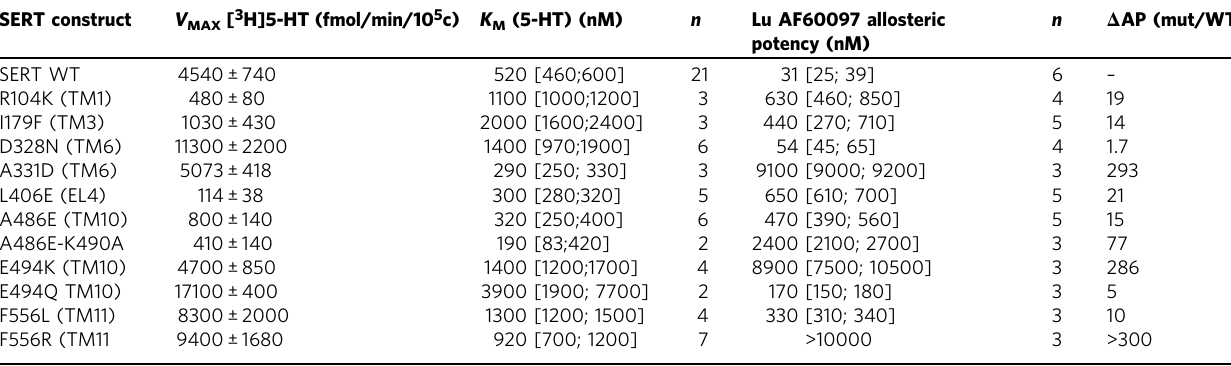
Table 2 Effect of Lu AF60097 in inhibiting [ 3 H]IMI dissociation from SERT WT and mutants. SERT